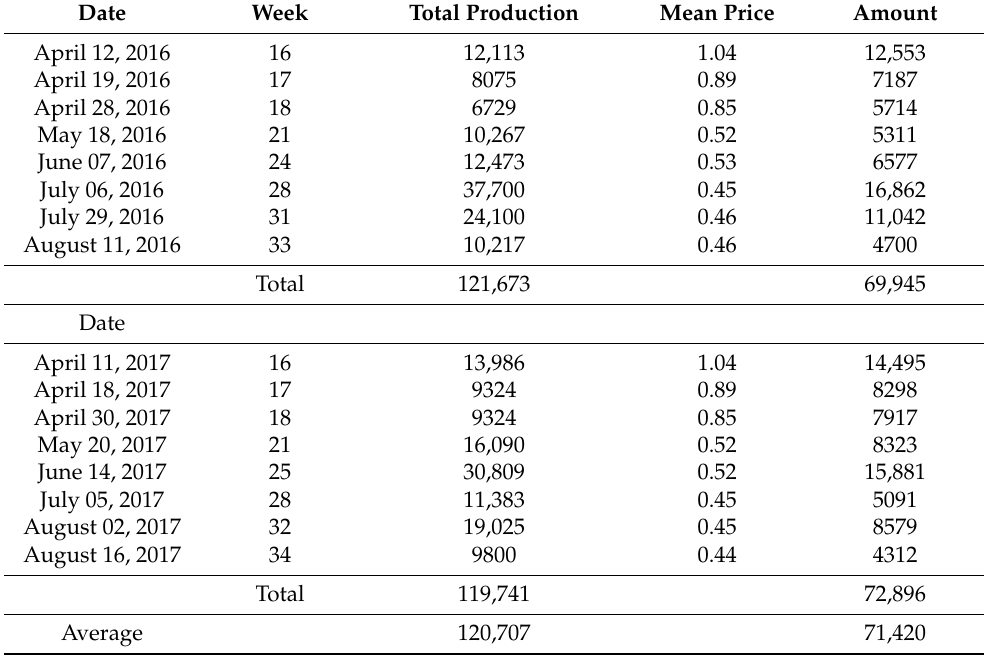
Table 7. Summary of annual income.